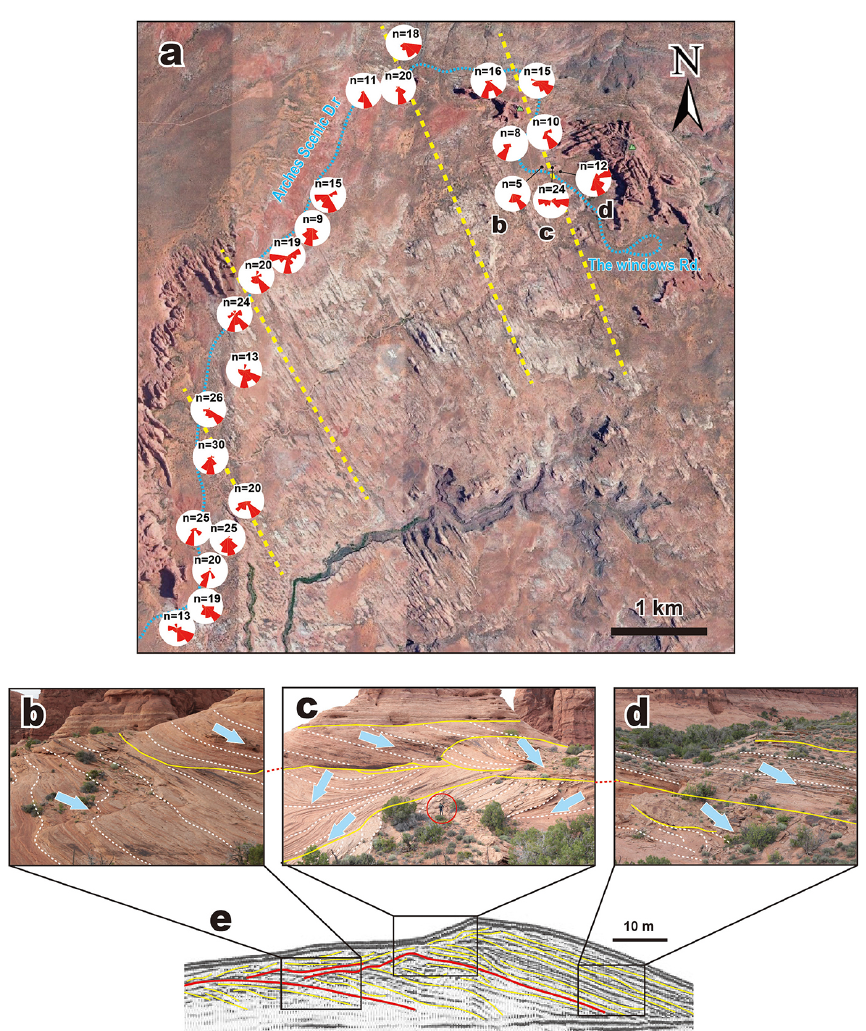
Figure 3. Spatial pattern of dune slip-face azimuths and outcrop photographs of the Navajo Sandstone in the Arches National Park, and comparison with the internal structure of a modern longitudinal dune. (a) Spatial distribution of palaeowind data along the Arches Scenic Drive. Yellow dotted lines are the inferred locations of the central crests of longitudinal dunes (© Google Earth 2016). (b–d) Outcrop photographs of cross-stratification structures in the Navajo Sandstone. Yellow solid lines and white dashed lines indicate bounding surface and slip-face cross-stratifications, respectively. All photographs were taken facing north. Red circle in (c) indicates a person for scale (ca. 1.7m tall). (e) Ground-penetrating radar (GPR) profile showing the internal structure of a modern longitudinal dune (Bristow et al., 2000). Yellow and red traces indicate slip faces and unconformities,